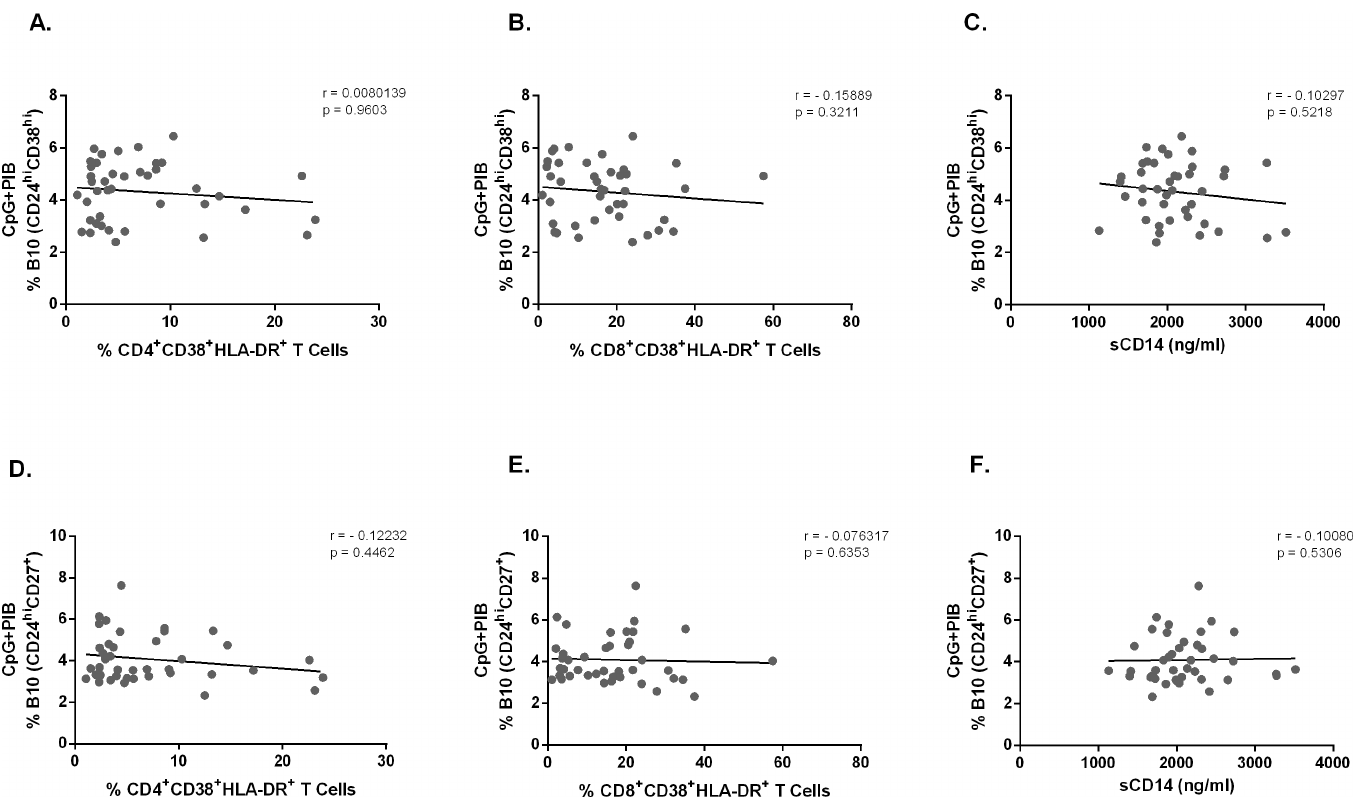
Fig 6. Correlation analysis of B10 cells and chronic activated T cells. The expression of intracellular IL-10 and surface markers CD24, CD38 and CD27 were determined by flow cytometry after in vitro stimulation of PBMC for 5h with CpG + PIB. Chronic activated T cells were determined in PBMC by the expression of surface markers CD4, CD8, CD38 and HLA-DR without stimulation and analyzed by flow cytometry. sCD14 levels in plasma were determined by ELISA. Correlation of CD19 + CD24 hi CD38 hi IL-10 + cells with chronic activated (A) CD4 + and (B) CD8 + T cells in 43 CVID patients. Correlation of CD19 + CD24 hi CD27 + IL-10 + cells with chronic activated (D) CD4 + and (E) CD8 + T cells in 43 CVID patients. Lines represent linear regression analysis. Correlation of CD19 + CD24 hi CD38 hi IL-10 + (C) and CD19 + CD24 hi CD27 + IL-10 + (F) B cells with plasma levels of sCD14 in 41 CVID patients. Lines represent linear regression analysis. R and P values were calculated by Spearman ’ s rank order correlation